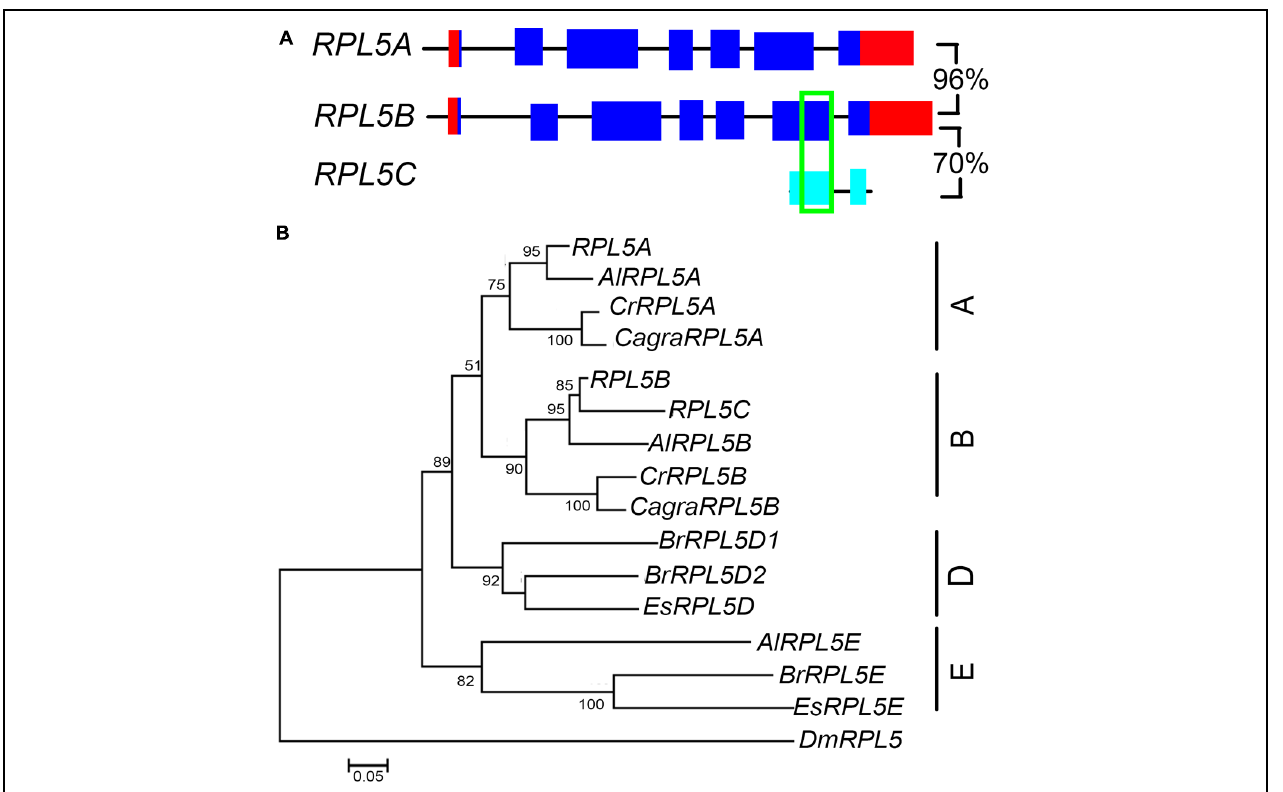
FIGURE 6 | RPL5 genes in Brassicaceae. Diagrammatic representation of A. thaliana RPL5 genes (A) showing UTR’s (red), exons (blue), non-coding upstream, and intron sequences (black line), exons of pseudogenes (light blue) and regions of 100% nucleotide identity (green). Percentage nucleotide sequence identity of exons is shown for genes and pseudogene. The phylogenetic tree of RPL5 genes in Brassicaceae (B) includes genes of species as listed in Figure 3